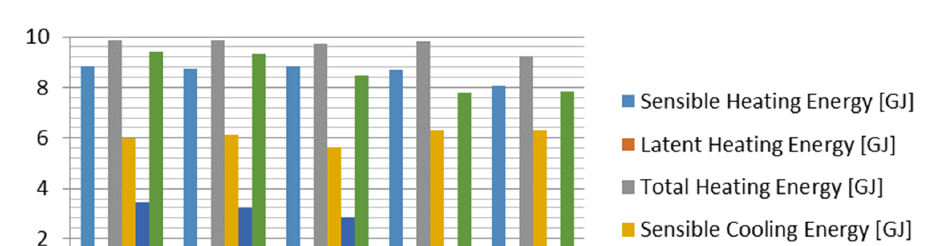
Figure 7. Ideal zone loads.